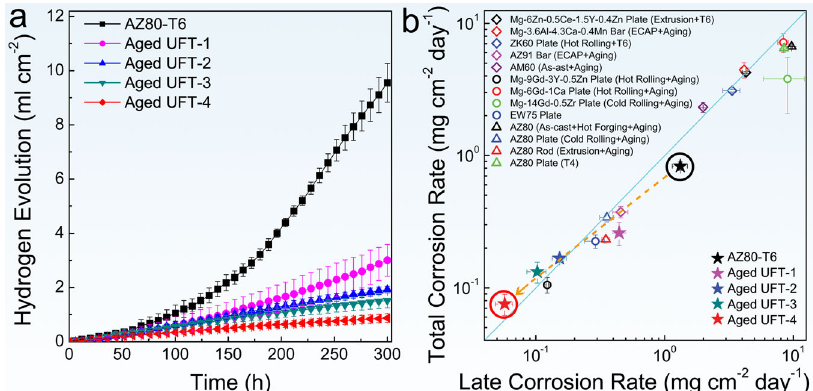
Fig. 3 Corrosion rates in 3 wt.% NaCl solution. ( a ) Corrosion rates as a function of time determined from the volume of hydrogen emitted. b Comparison of the corrosion rates between the aged UFT samples and typical precipitate-hardened Mg – Al, Mg – Zn, and Mg – RE alloys. Error bars in ( a ) and ( b ) represent one standard deviation of the data from the mean. The x-axis is the corrosion rate for the last 24 h and the y-axis is the average corrosion rate for 300 h. If the symbol is above the blue line, the corrosion rate decreases with time, otherwise it increases with time. ECAP in ( b ) refers to an equal channel angular process.